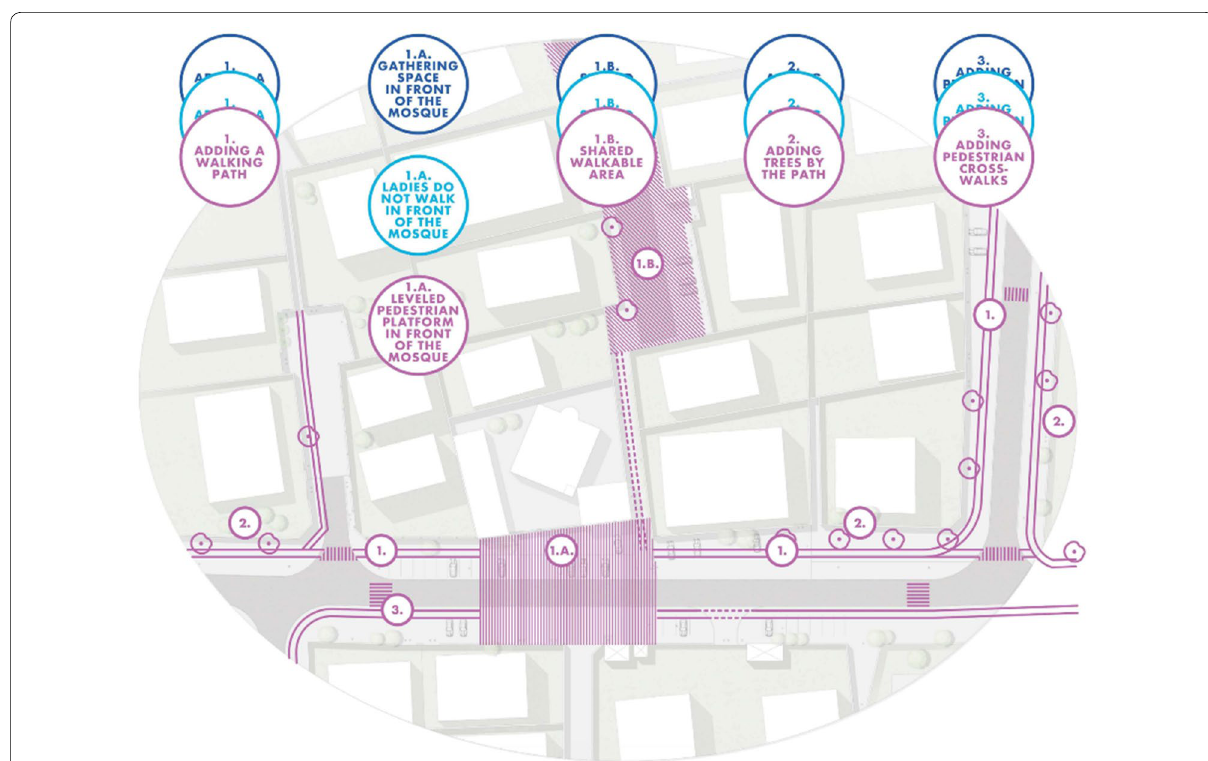
Fig. 10 A visual collection of overall comments and design proposals of both male and female workshops in the neighborhood of Al Hail. Generally, both workshops proposed similar elements (though employing different solutions), which is represented in this graphic in purple, to tackle the spatial problems. The area in front of the mosque had the most contrasting proposals and very different elements were recommended, which are represented by dark blue circles for the male workshop responses, and in light blue for the female workshop responses. Such compilations of ideas and responses by residents is what was ultimately used by the students to design the